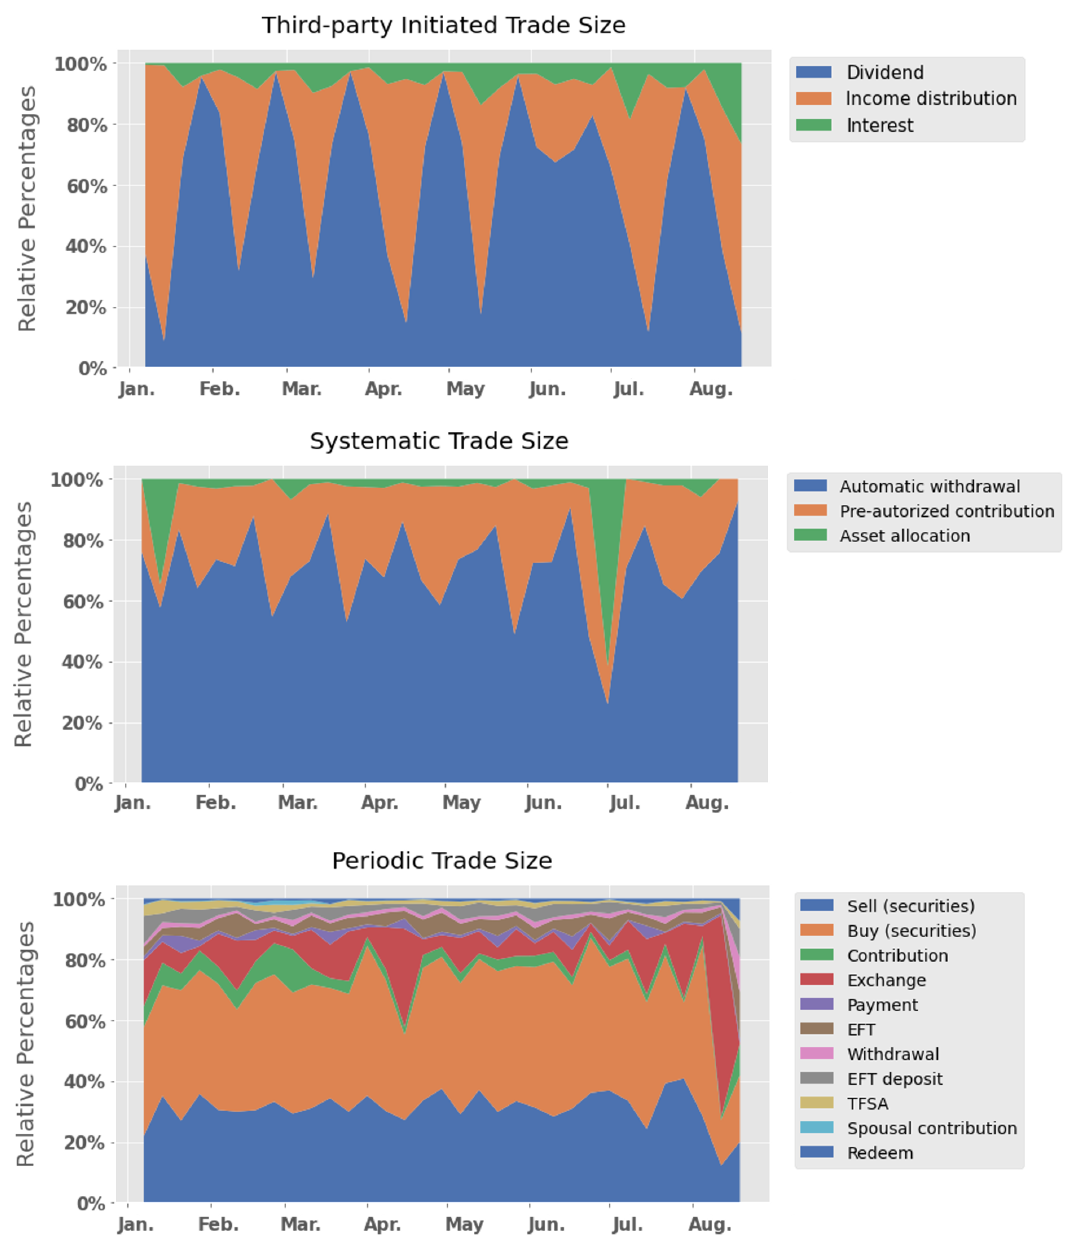
Figure 4. The relative percentage of transactions sizes from the three behavioral metrics versus time (January to August 2019). Top, middle, and bottom panels correspond to third-party-initiated, systematic, and periodic trades,